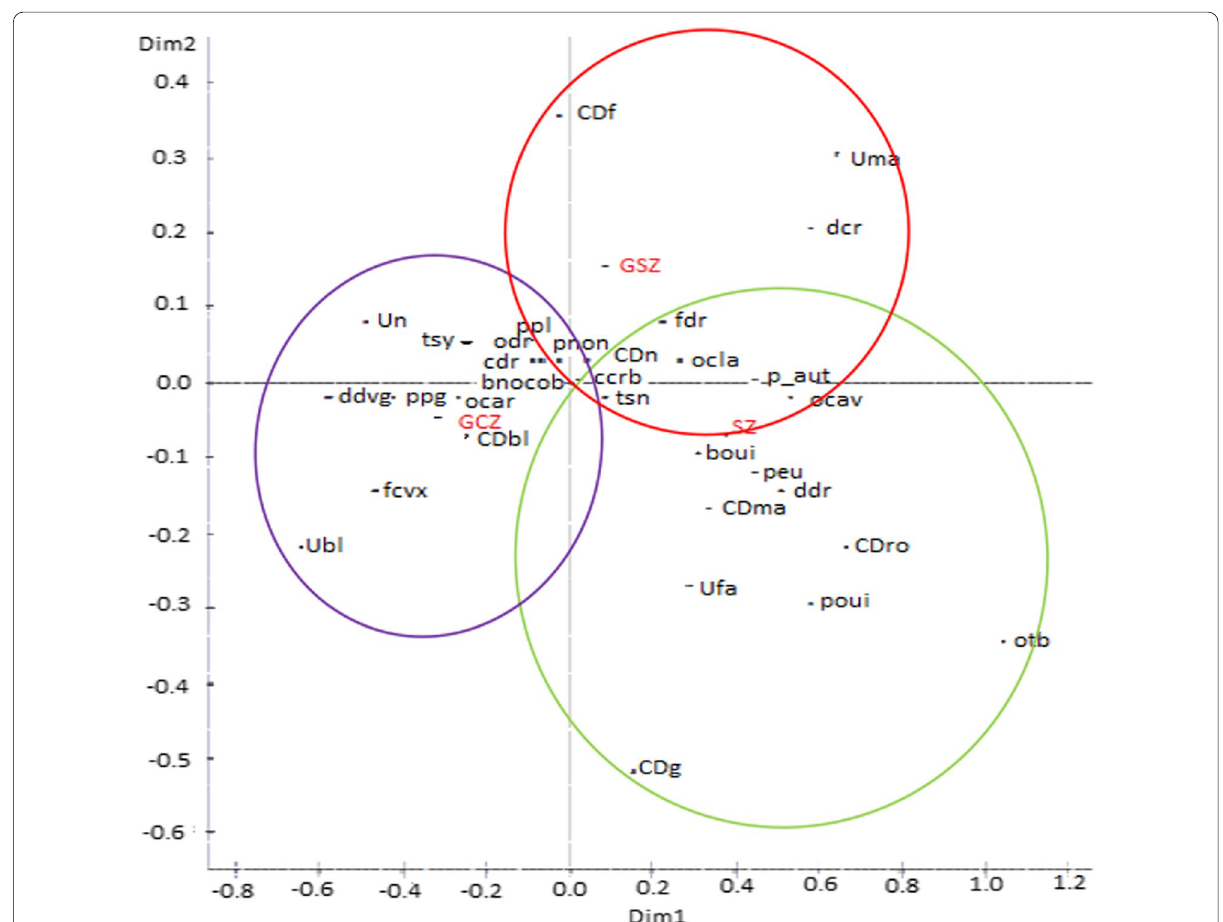
Fig. 5 Multiple correspondence analysis of the morphological physical traits of goat population in Benin; GCZ Guineo-Congolese zone, GSZ Guineo-Sudanian zone, SZ Sudanian zone. tsn absence of supernumerary teats, tsy presence of supernumerary teats, fdr straight facial, fcvx concave facial, odr erected ear, otb dropped ear, Un uniform black, Uma uniform brown, Ubl uniform white, Ufa uniform fawn, CDbl spotted white, CDf spotted fawn, CDg spotted grey, CDma spotted brown, CDn spotted black, CDro spotted red, peu eumelanic, ppl localized variegation, ppg generalized variegation, p_ aut other pigment patterns, ddr straight back, dcr dipped/curved back, ddvg back with slopes up towards the rump, bnon absence of beard, boui presence of beard, pnon absence of wattles, poui presence of wattles, cdr straight horn, ccrb curved horn, ocla lateral